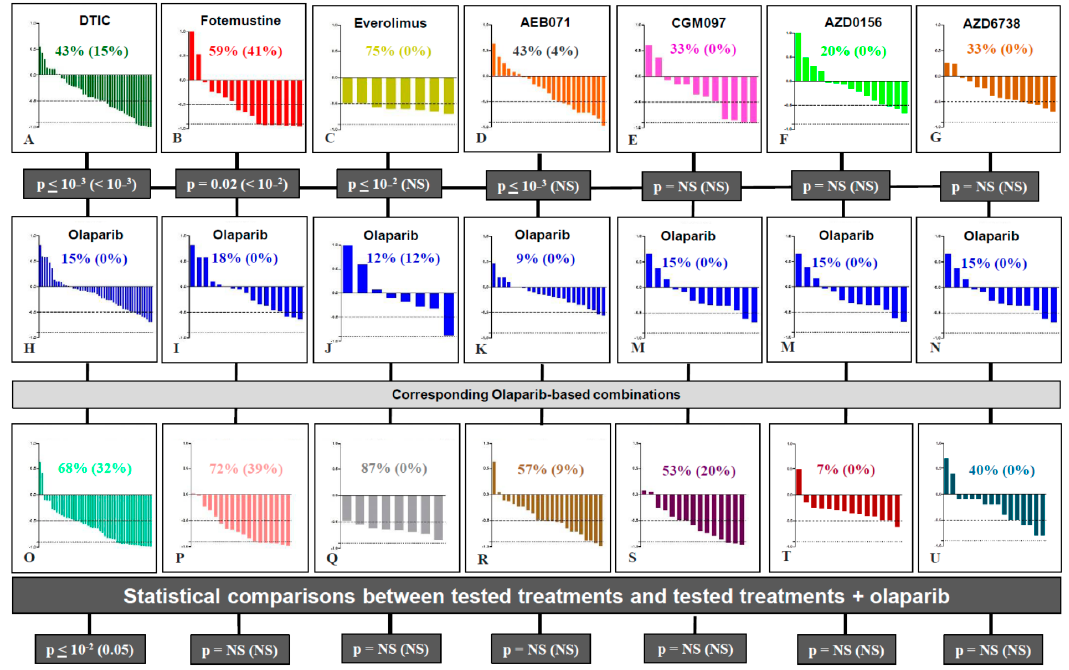
Figure 2. Waterfall plots of response to olaparib-based therapies. Upper p values correspond to statistical di ff erences between olaparib compared to each other tested treatment; p values at the bottom correspond to statistical di ff erences between each tested treatment compared to its combination with olaparib ( χ 2 test).